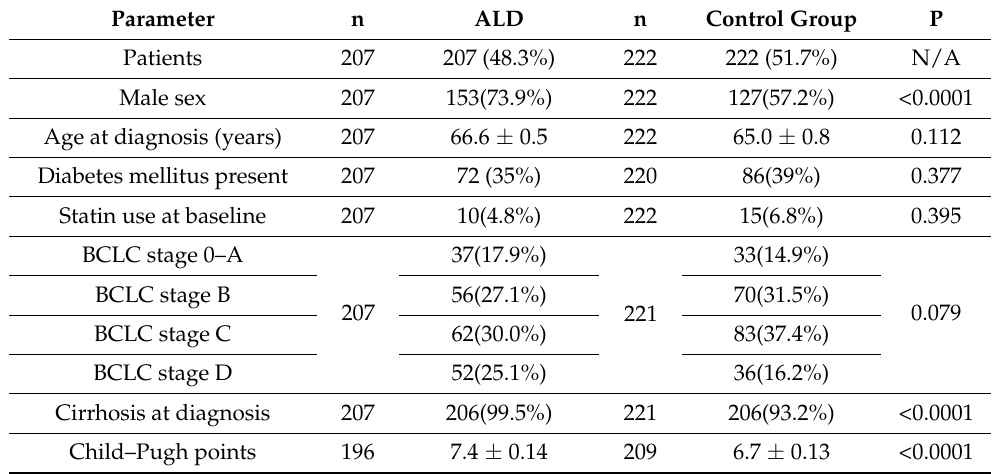
Figure 1. Flowchart of the study analysis according to STROBE guidelines. Table 1. Etiology of chronic liver disease. Table 2. Baseline characteristics of the study